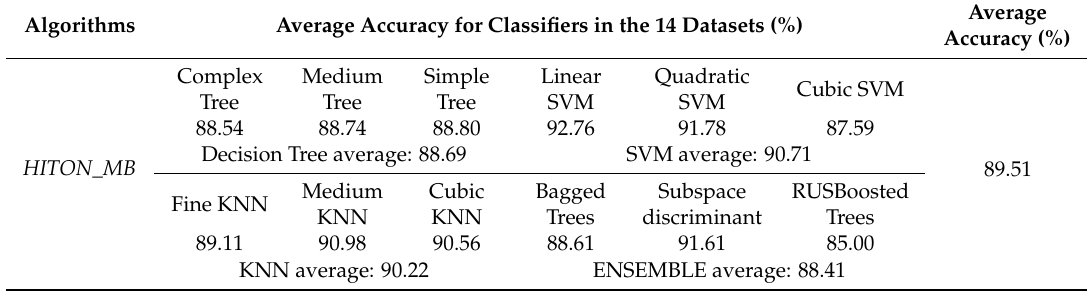
Table 10. Average prediction accuracies of HITON_MB